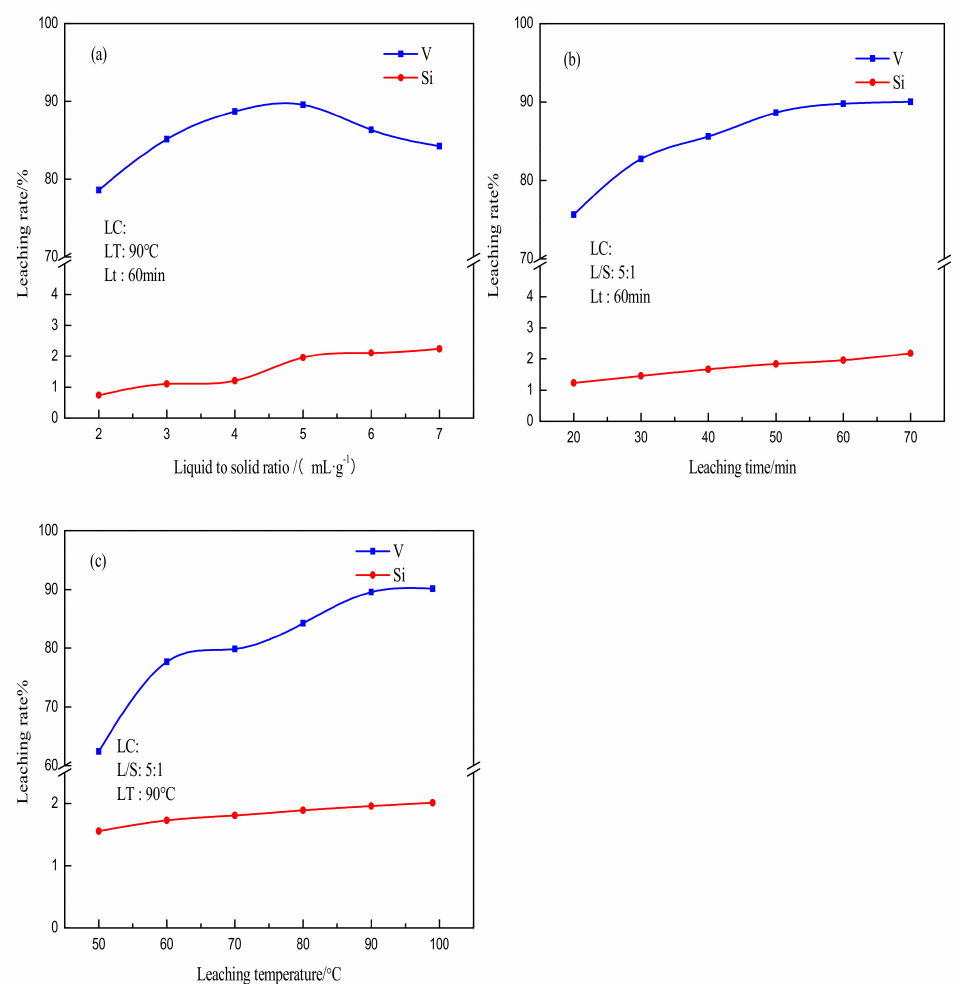
Figure 3. Effects of leaching liquid-solid ratio ( a ), leaching time ( b ), and leaching temperature ( c ) on vanadium leaching rate.